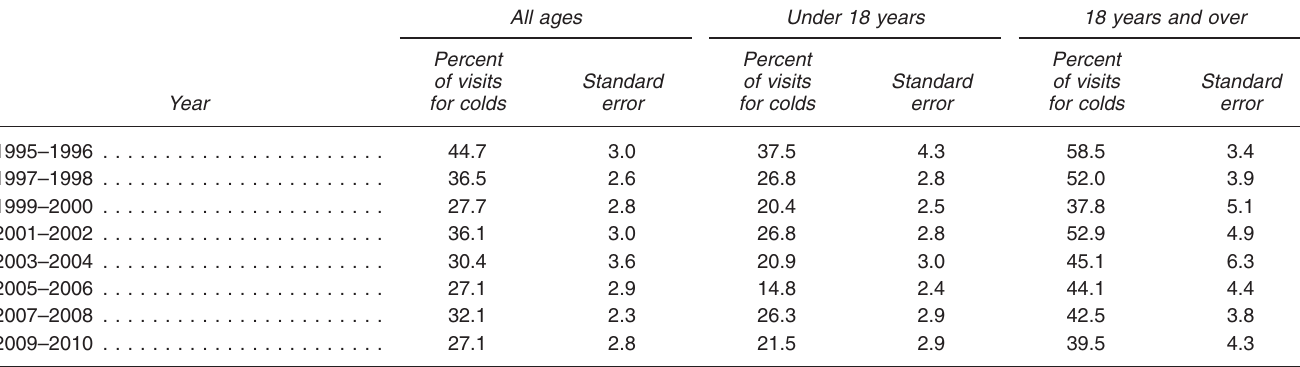
Data table for Figure 26. Antibiotics ordered or provided during emergency department, outpatient, and physician visits for cold symptom diagnoses, by age: United States, average annual, 1995–1996 through 2009–2010 Excel and PowerPoint: http://www.cdc.gov/nchs/hus/contents2013.htm#fig26